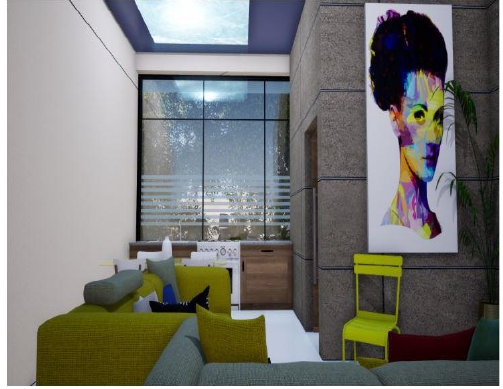
Figure 1. Interior with colour and artwork Figure 2. The exterior of a courtyard with